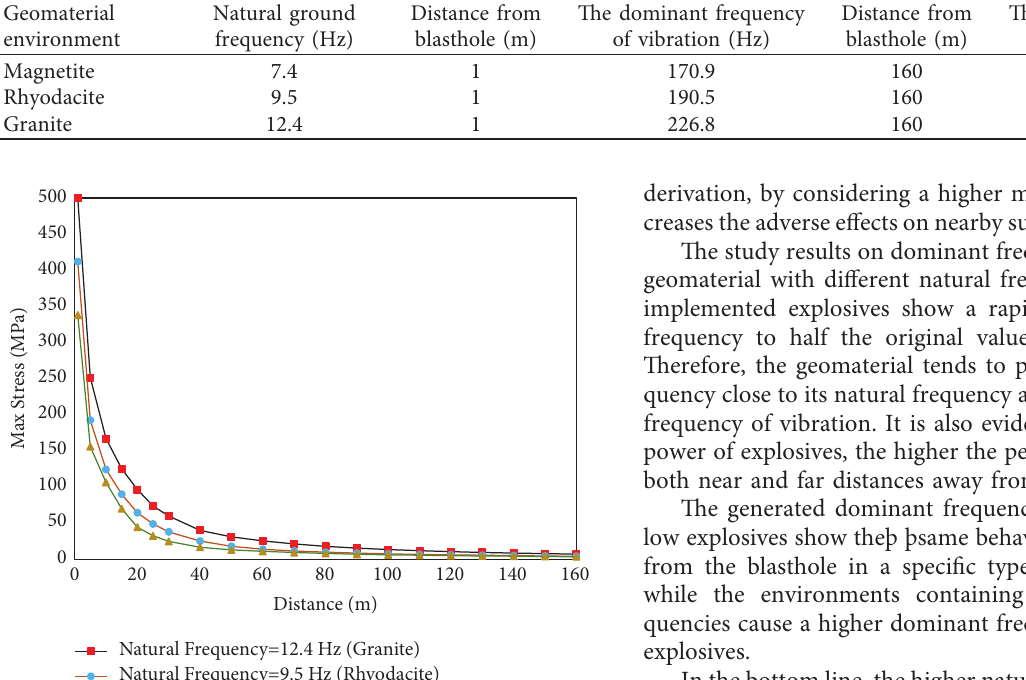
Figure 16: The relationship between maximum stress and distance for materials containing different natural